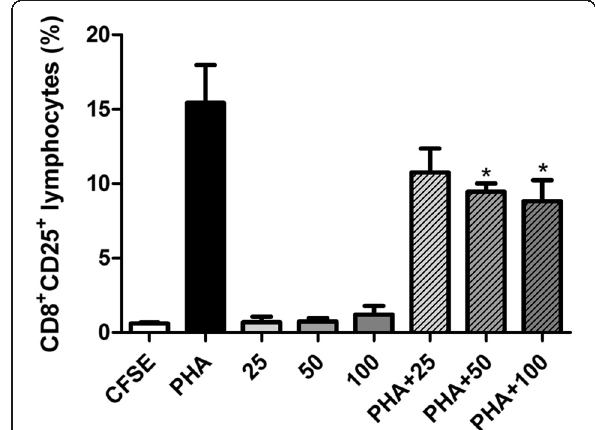
Fig. 3 Percentage of CD8 + T lymphocytes expressing CD25. Peripheral blood mononuclear cells (PBMC; 5 × 10 6 cells/mL) were labeled with carboxyfluorescein diacetate succinimidyl ester (CFSE; 2.5 μ M) and cultured with Tityus serrulatus scorpion venom (TsV; 25, 50, and 100 μ g/mL) alone or in combination with phytohemagglutinin (PHA; 2 μ g/mL) for 96 h at 37 °C, and under 5 % CO 2. Then, PBMC were collected, labeled with anti-CD3/PerCP, anti-CD8/PE, and anti-CD25/APC monoclonal antibodies, and further analyzed by flow cytometry. CFSE: CFSE-stained cells cultured in RPMI; PHA: PHA-stimulated cells (positive control); 25, 50, 100: cells incubated with 25, 50, and 100 μ g/mL TsV, respectively; PHA+25, PHA +50, PHA+100: cells incubated with PHA plus 25, 50 and 100 μ g/mL TsV, respectively. Each column represents the mean±SEM of five experiments.* p <0.05 vs.